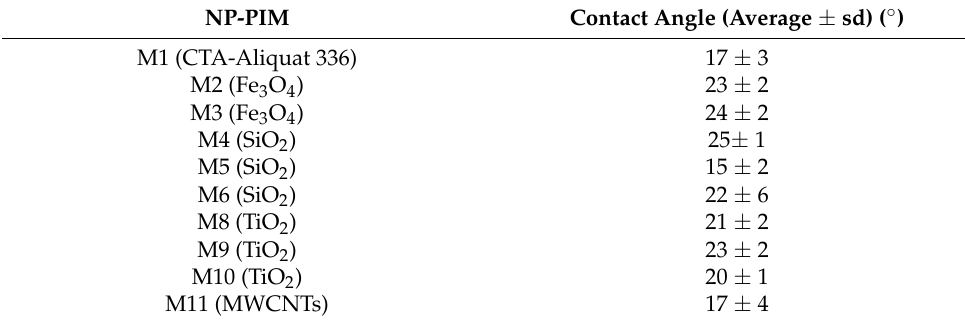
Figure 4. SEM images of the different PIMs: ( a ) M1; ( b ) M2 (0.5% Fe 3 O 4 ); ( c ) M4 (1% SiO 2 ); ( d ) M8 (1% TiO 2 ); ( e ) M11 (MWCNTs). Table 2. Results of contact angle